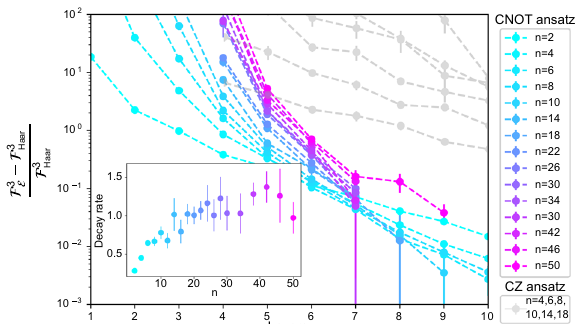
Fig. 8 Fractional deviation of the k = 3 frame potential from the Haar value as a function of layers for hardware-ef fi cient ansätze. Colorful traces are for the CNOT gate-based ansätz, and gray traces are for the CZ gate-based ansätz. Error bars show one standard error. The inset shows the CNOT ansätz decay rate scaling of F in the number of qubits n . Error bars show one standard